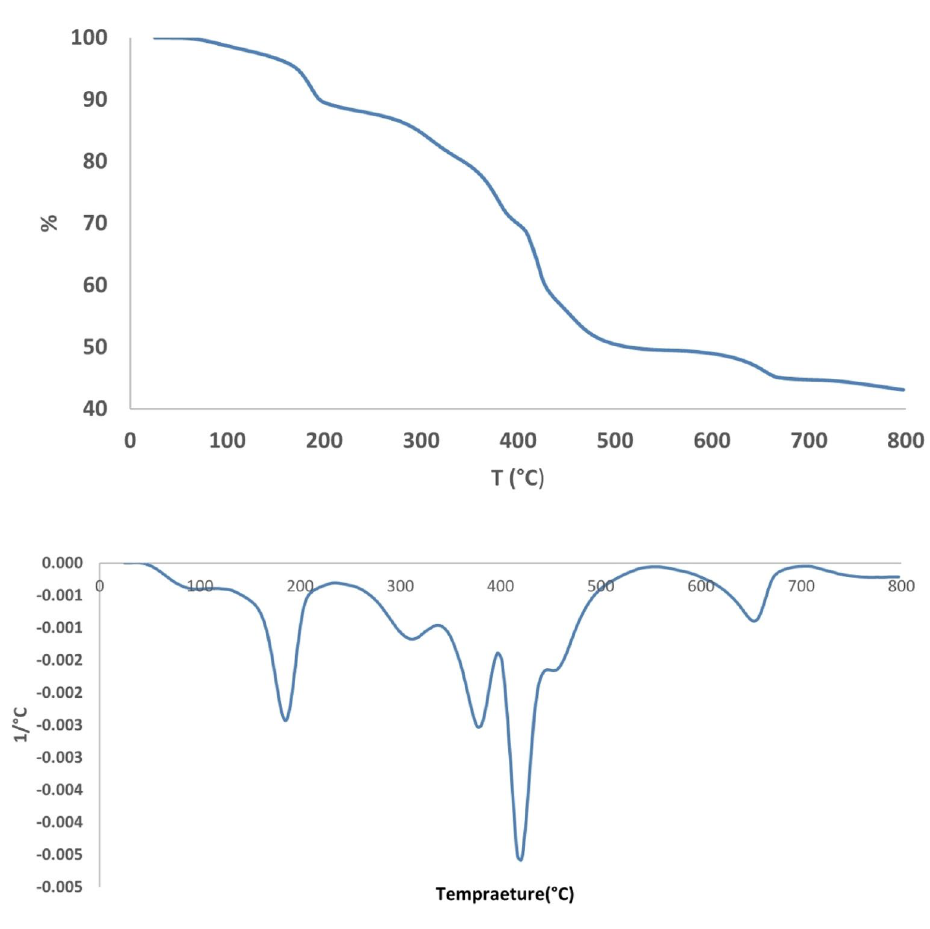
Figure 9. TGA-DTG